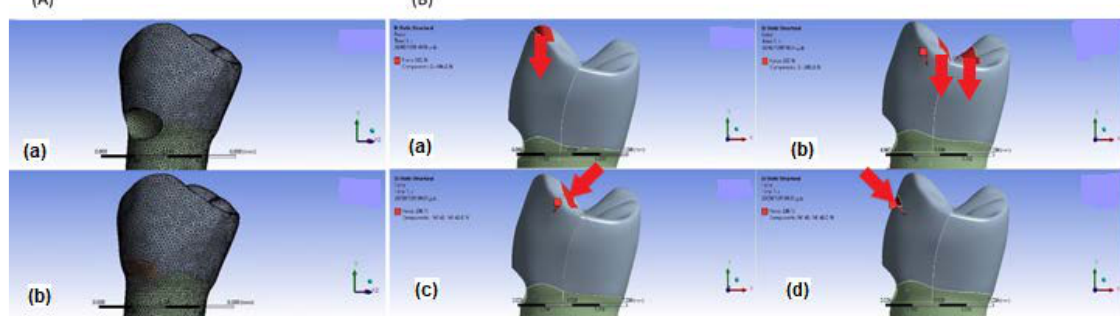
Figure 1. ( A ) Finite element meshed models of mandibular first premolar tooth. ( a ) Unrestored model, ( b ) Restored model. ( B ) The finite element model under the various loading sites; the direction and location of occlusal forces are illustrated with red regions and arrows on the tooth surface. ( a ) Buc.T, ( b ) Cent, ( c ) Buc.L, ( d ) Buc.B .